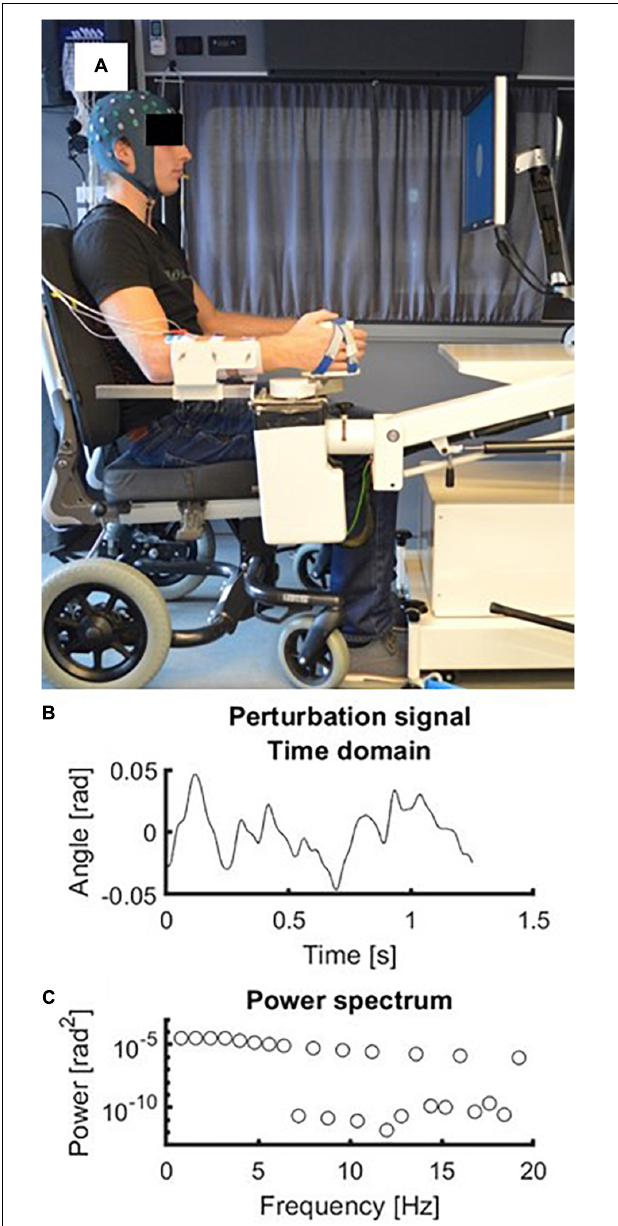
FIGURE 1 | Experimental setup. (A) Picture of the experimental setup with a subject wearing the EEG cap and with his forearm strapped in the handle of the robot. (B) Time domain representation of the perturbation signal. Zero radians represents the neutral position of the wrist at 0.35 rad (i.e., 20 degrees) flexion. (C) Frequency domain representation of the perturbation signal. Frequencies above 4 Hz had decreasing amplitudes ( − 20